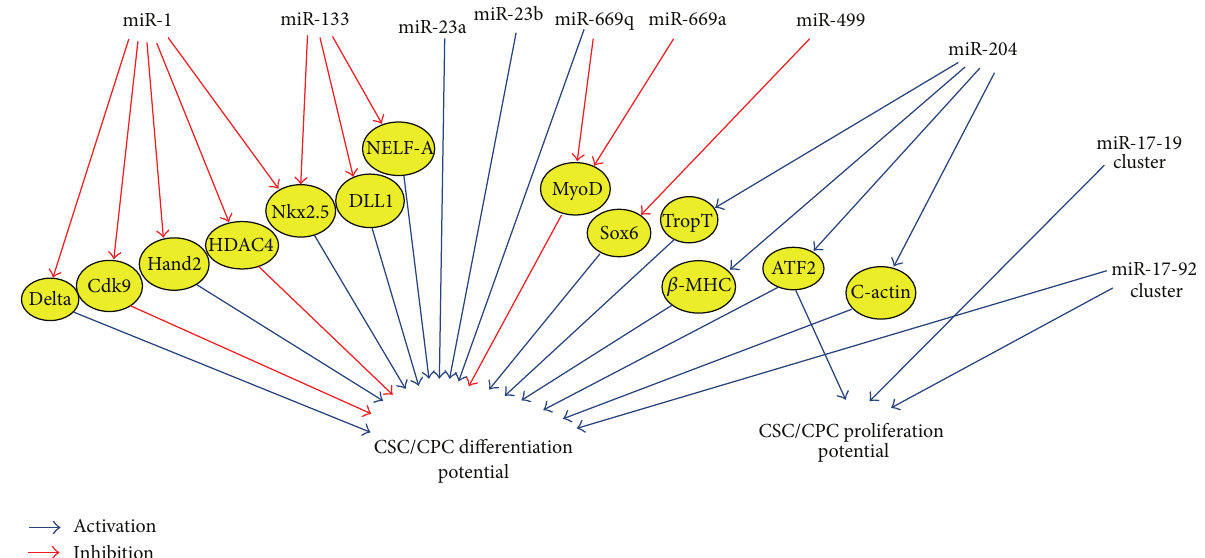
Figure2:SummarydiagramillustratingthecellularinteractionsofvariousmiRsubtypesandclusterswithregardtotheirroleofregulatingthe differentiation and proliferation potentials of cardiac stem cells (CSCs) and progenitor cells (CPCs). These miRs target specific transcription factors and cardiac genes (yellow circles) and inhibit their protein expression, causing a downstream effect on stem cell differentiation and proliferation (inhibition is indicated by the red arrows and activation is indicated by blue